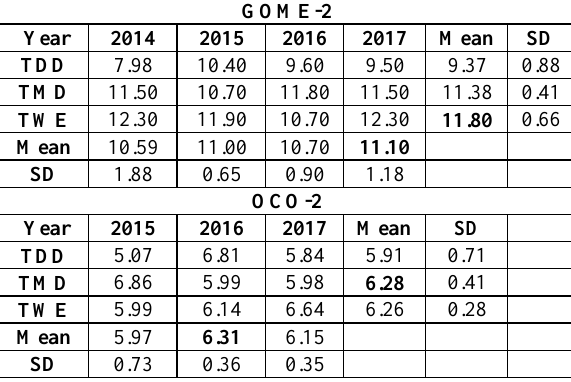
Table 2: Time integrated SIF (tSIF) from GOME-2 and OCO-2 Annual tSIF estimated from GOME-2 (tSIF GOME-2 ) was higher than tSIF from OCO-2 (tSIF OCO-2 ) for almost all year (Table 2). Total tSIF was lowest for TMD forest type than TMD and TWE estimated from both the SIF sensors. tSIF GOME-2 of TDD for year 2016 and 2017 is almost same whereas, tSIF OCO-2 shows highest value for year 2016 instead of 2015, as rainfall was also recorded higher for the same year. Yet, tSIF for year 2015 shows little anomaly as OCO-2 estimates higher for TMD and lower for TDD and TWE but GOME -2 estimates highest for TDD than TMD and TWE. TWE shows highest photosynthetic activity than TMD and TDD forest type.